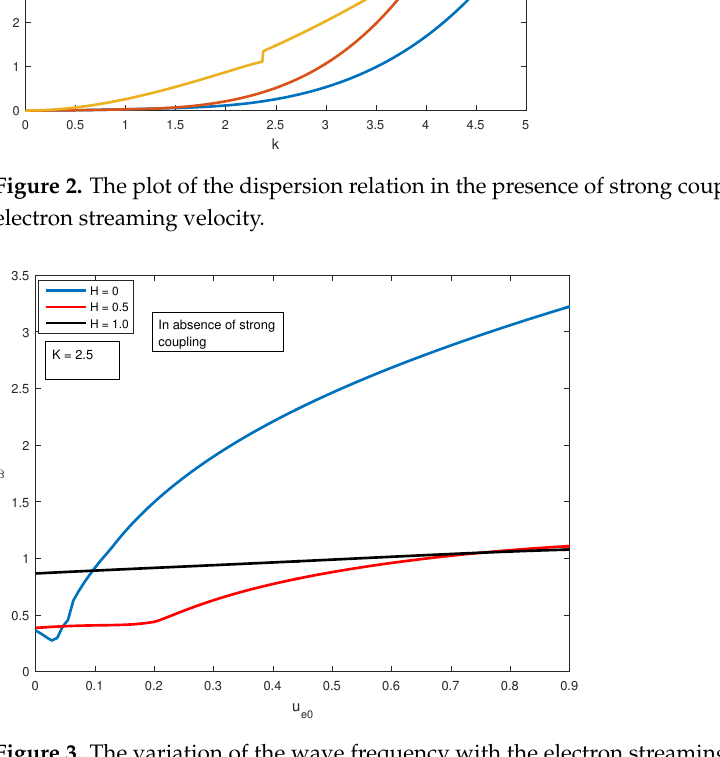
Figure 3. The variation of the wave frequency with the electron streaming velocity. In this case, we see that the wave frequency varies quite clearly with the quantum parameter ‘ H